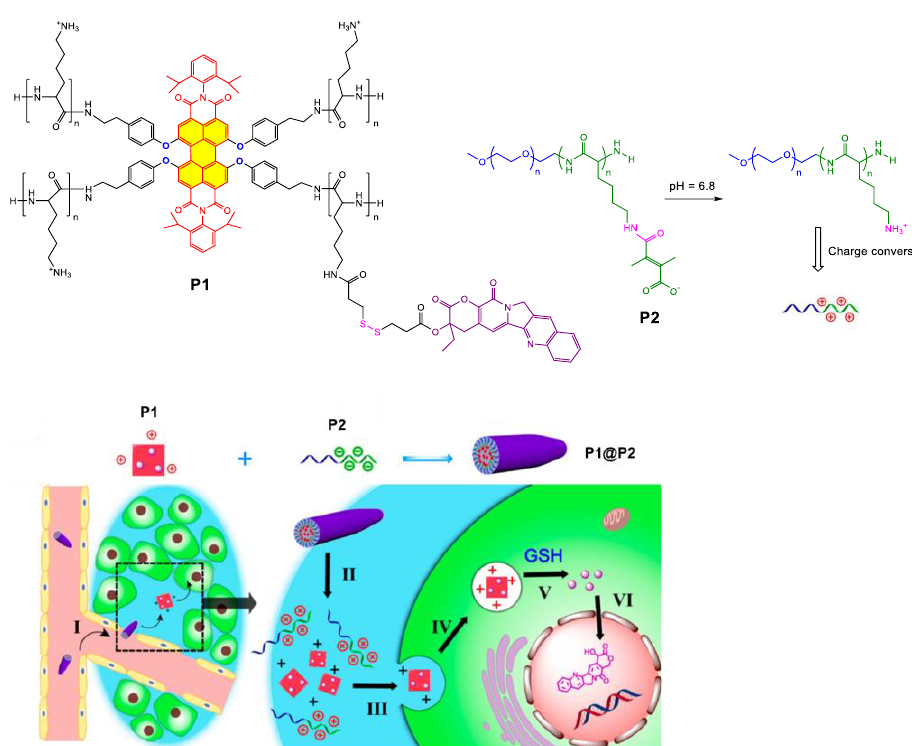
Figure 17. Chemical structures of P1, P2 and P1@P2 complex; illustration of the CPT-delivery process using the P1@P2 supramolecular complex. Adapted and reprinted with permission from reference [122]. Copyright 2017 American Chemical Society.